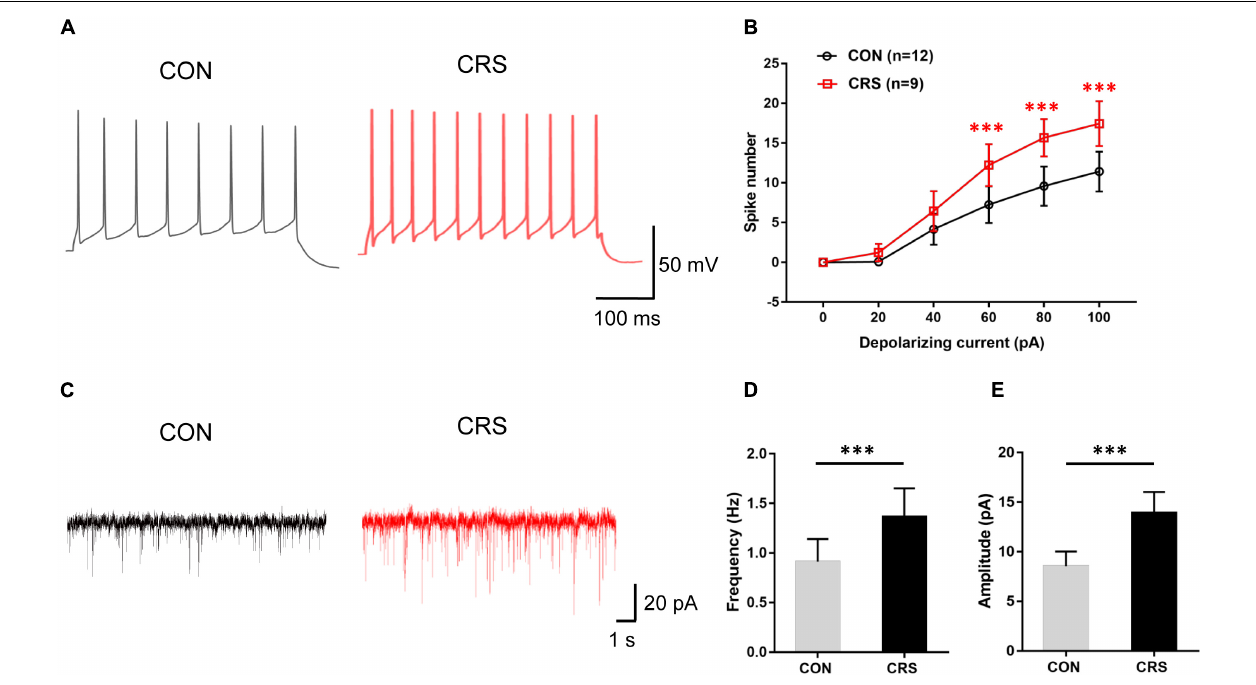
FIGURE 2 | Effects of chronic restraint stress on action potential (AP) frequency and spontaneous excitatory postsynaptic currents (sEPSCs) of Vme neurons. (A) Representative traces evoked by intracellular injection of 80-pA depolarizing currents on Vme neurons from CON and CRS mice for 400 ms. (B) Data analysis showing that the firing numbers of APs from the CRS group were significantly increased compared with those from the CON group with injection of 60, 80, and 100 pA. (C) Representative traces of sEPSCs in Vme neurons recorded in the CON and CRS groups. Both frequency (D) and amplitude (E) were significantly higher in CRS mice than in CON mice. ∗∗∗ P <